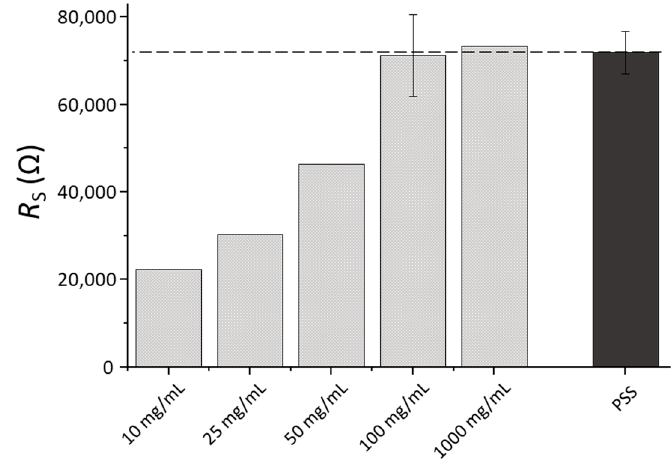
Figure 4. R S values of 3D-IDEA modified with PEI and different concentrations of Con A (10, 25, 50, 100, and 1000 µg·mL − 1 ) and after the addition of PSS.